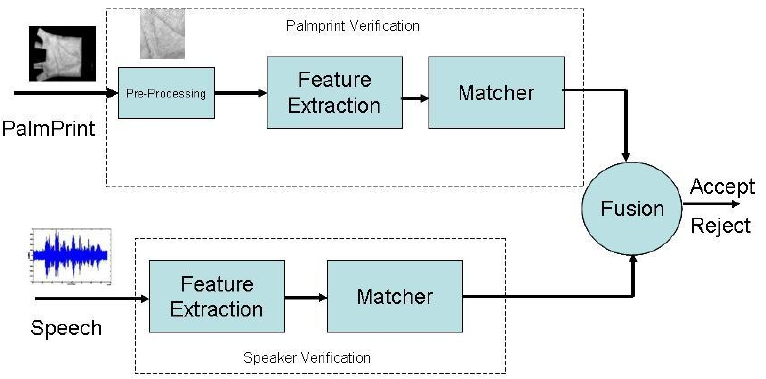
Figure 1. Block diagram of the proposed multimodal biometric